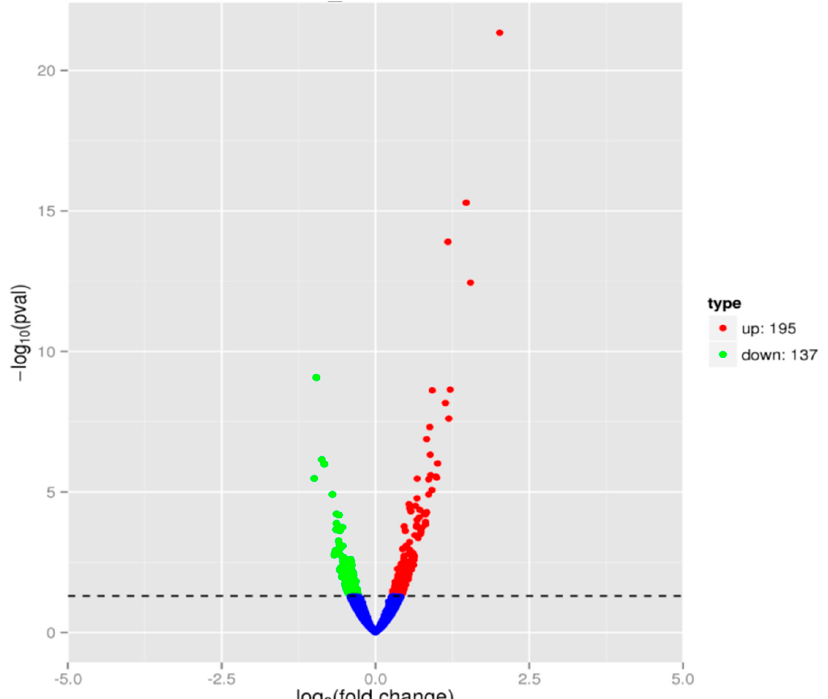
Figure 1. Volcano plot of differentially expressed genes (DEGs). In total, 332 genes present different expression levels. Red indicates upregulated expression, green indicates downregulated expression and blue indicates no significant differential expression when comparing Q_BITC with the C_BITC sample.